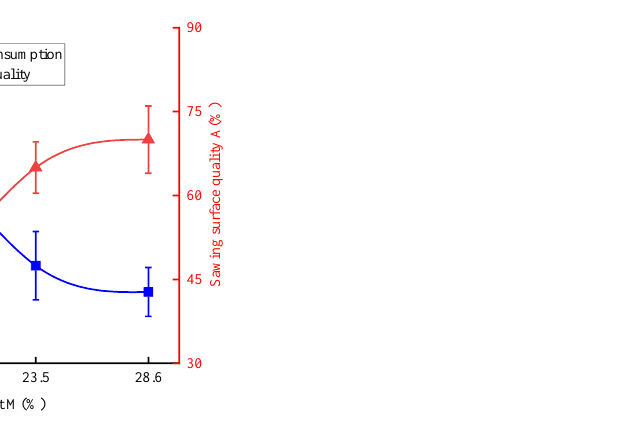
Figure 11. Sawing performance with different moisture contents (Note: Branch diameter 10–12 mm;